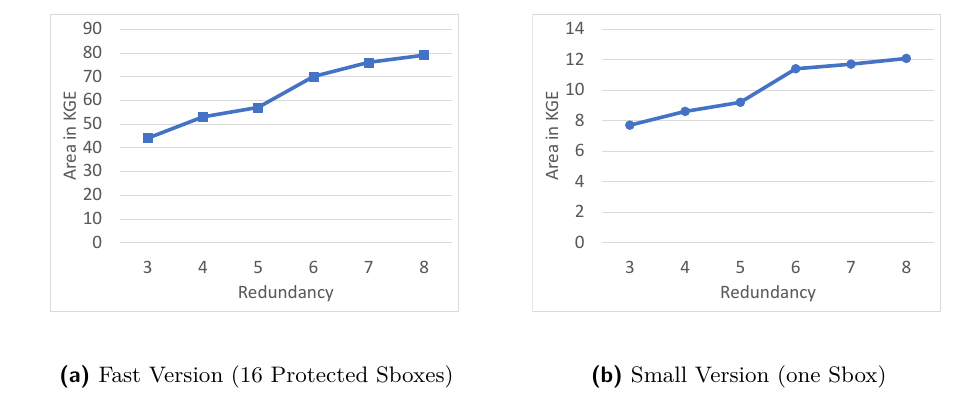
Figure 6: Area as a Function of the Redundancy